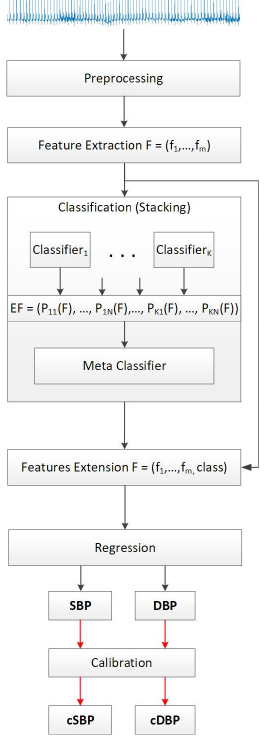
Figure 1. Proposed methodology for blood pressure